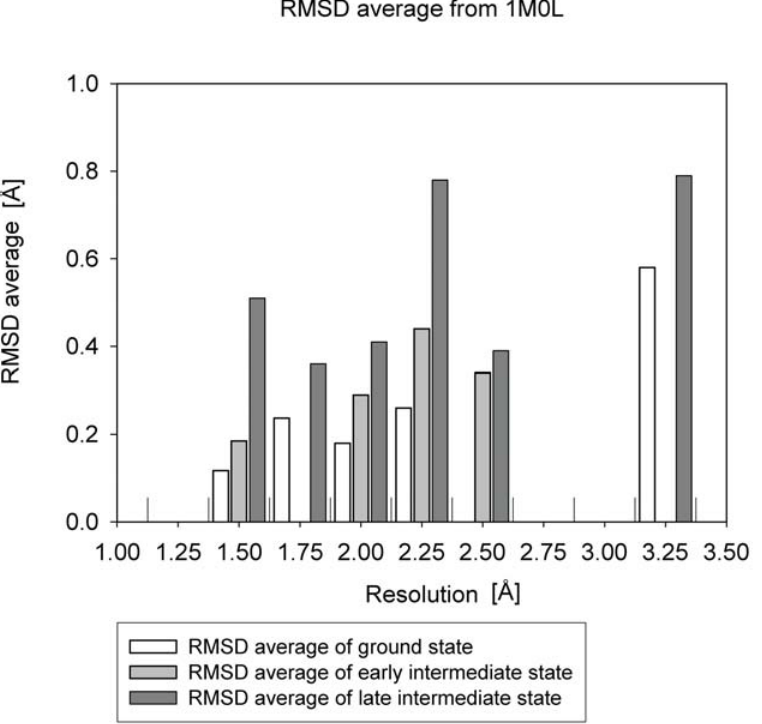
Figure 11. RMSD average of ground, early, and late intermediate state coordinates from 1M0L ground state coordinates. The height of each vertical bar represents the average value of RMSD in that resolution range (0.25 A˚ interval). 10 early intermediate and 6 late intermediate coordinates (Table 1) are used for each calculation. 15 ground state coordinates (Table 1) are used for calculation of ground state. All RMSD values used for this figure are listed in Fig. S1. Furthermore, structural distribution of late intermediate coordinates is discussed in Fig. S2.